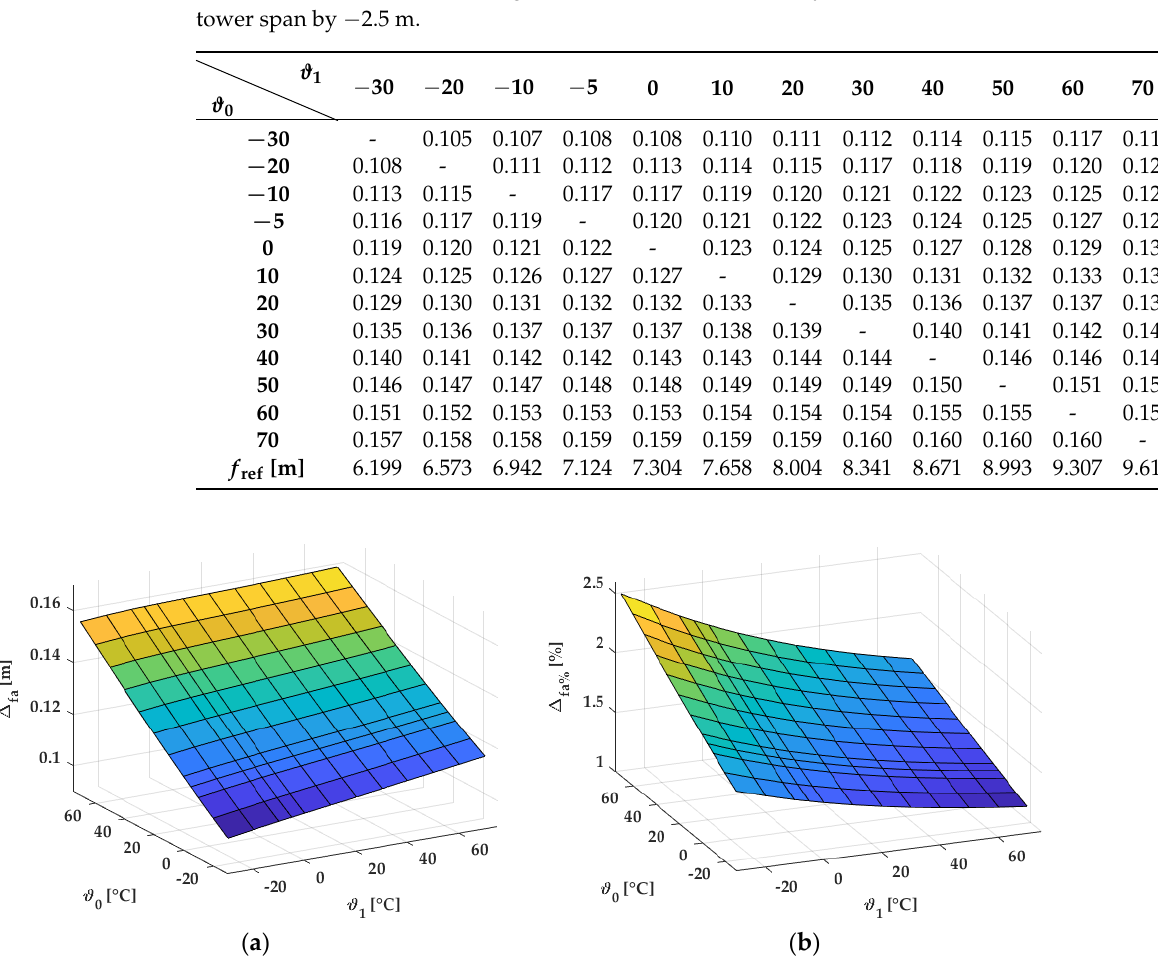
Figure 15. The dependence of sag deviations caused by the incorrect determination of tower span by − 2.5 m: ( a ) Absolute sag deviations; ( b ) percentage sag deviations.